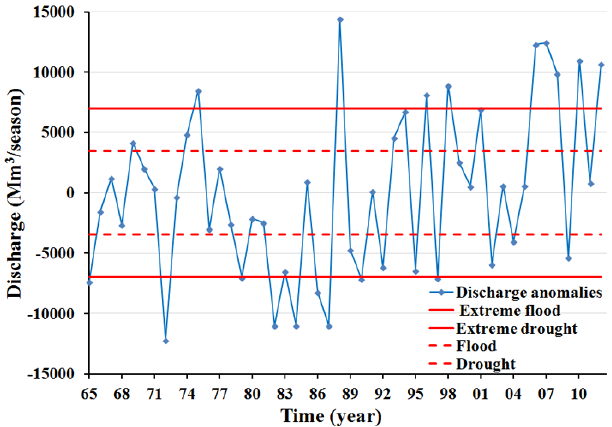
Fig. 5. The discharge anomalies at Eldiem station averaged over JJAS (1965–2012), the red line represents the threshold for the ex- treme flood/drought, and the dashed red line represents the thresh- old for